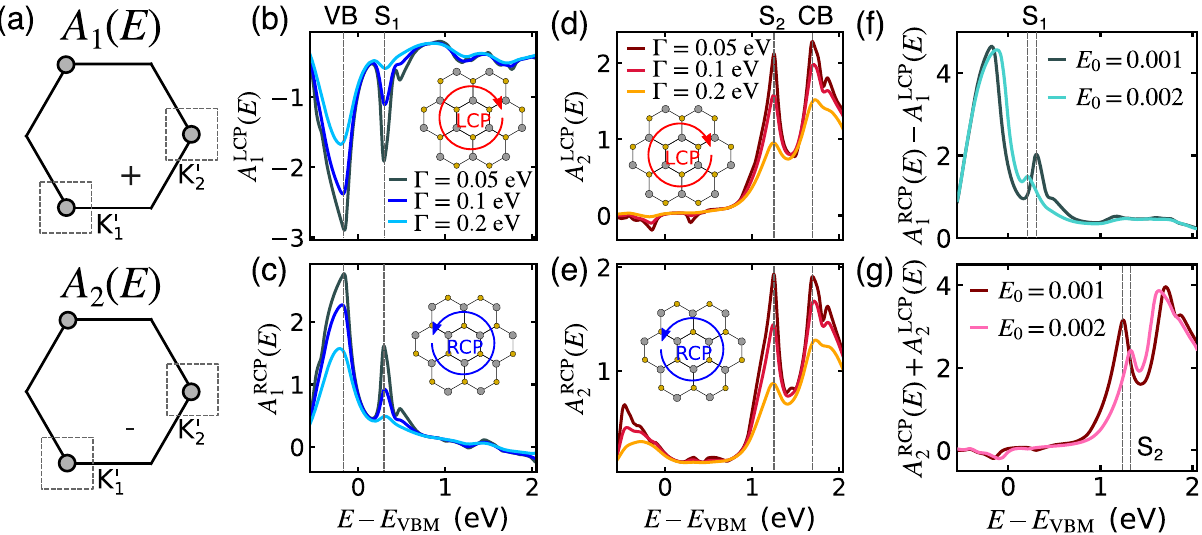
Fig. 6 Dichroic markers and robustness against dissipation. a Illustration of the de fi nition of the dichroic markers A 1,2 ( E ) for the side bands S 1,2 . b dichroic marker A 1 ( E ) for the orientation and left-hand circularly polarized pump as in Fig. 5a, and c for orientation and right-hand circularly polarized pump as in Fig. 5f. d , e dichroic marker A 2 ( E ) for crystal orientation as in b , c . The pump fi eld strength is E 0 = 2 × 10 − 3 a.u. in b – e , and the signal for different bath coupling strength Γ is shown. We also indicate the position of the valence band (VB), side band band ( S 1,2 ), and conduction band (CB) peaks. f Time- reversal difference of the marker A 1 ( E ) for Γ = 0.1 eV for different fi eld strength of the pump. The dashed lines in b , c , f indicate the position of the side band S 1 , while they indicate S 2 in d , e , g